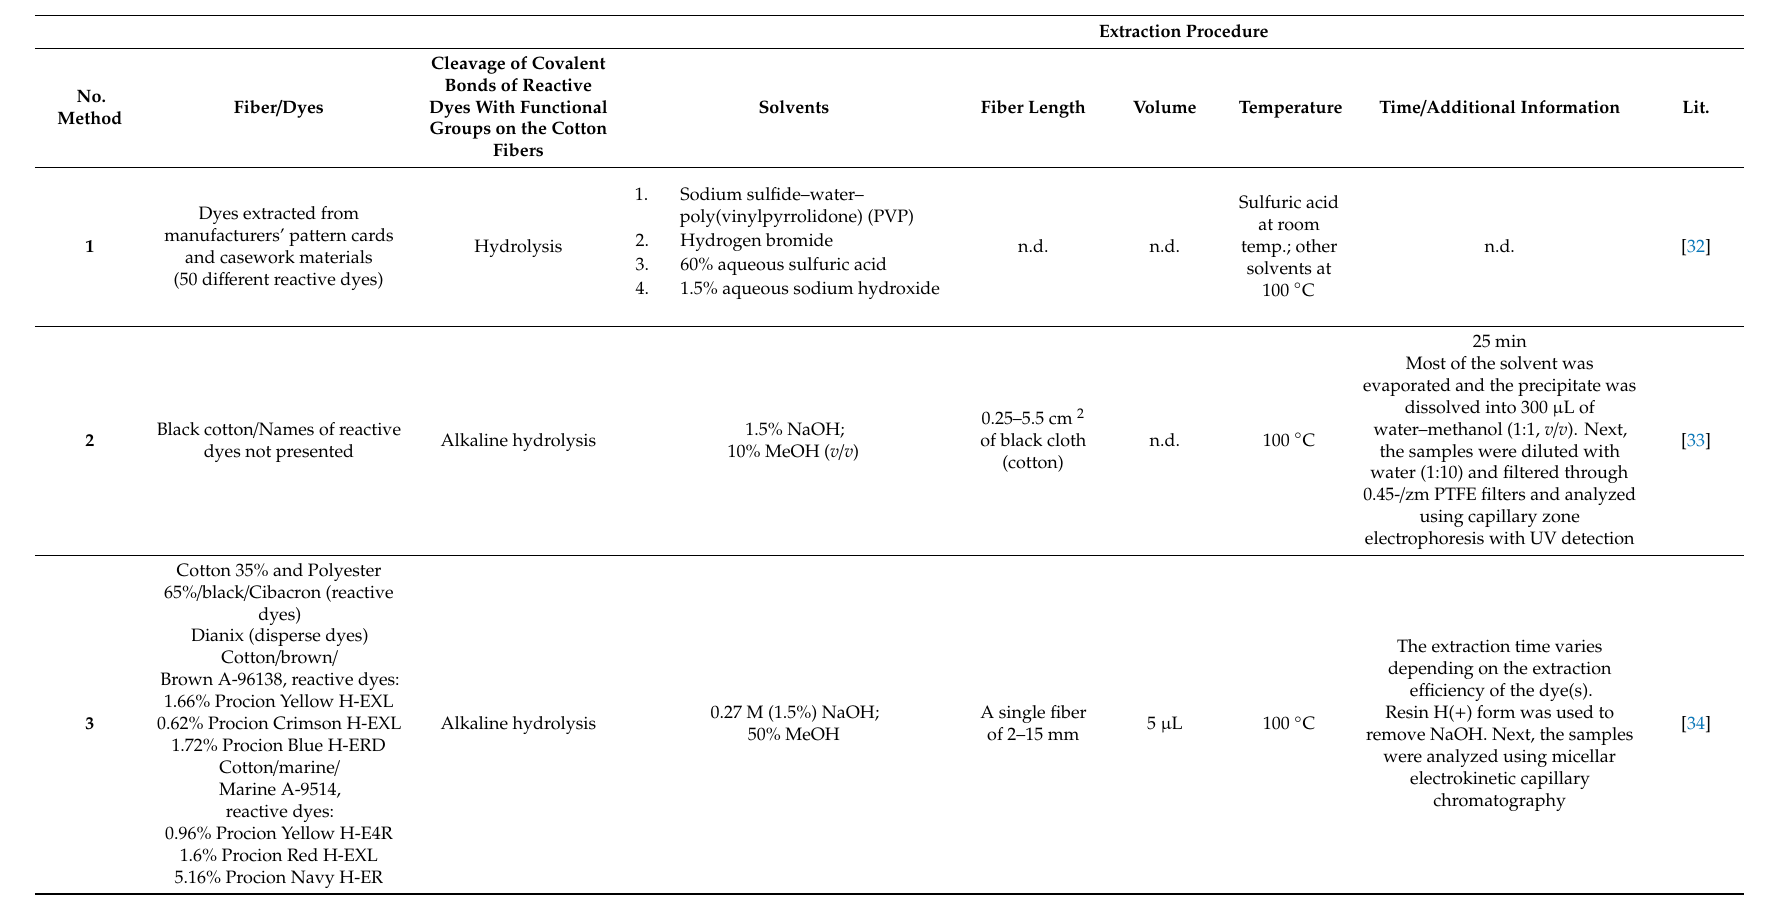
Table 2. Overview of extraction procedure for isolation of reactive dyes from dyed cotton fibers described in the literature.